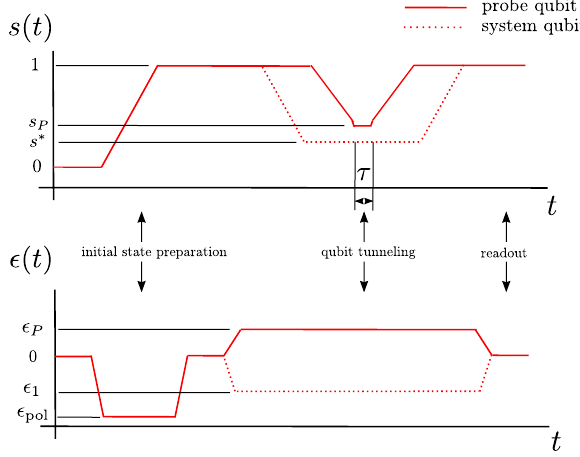
FIG. 7. Typical waveforms during QTS. We prepare the initial state by annealing probe and system qubits from s ¼ 0 to s ¼ 1 in the presence of a large polarization bias ϵ . We then bias the pol system qubit q 1 (to which the probe is attached) to a bias ϵ 1 and the probe qubit to a bias ϵ . With these biases asserted, we then P adjust the system qubits ’ annealing parameter to an intermediate point s (cid:4) and the probe qubit to a point s and dwell for a time τ . P Finally, we complete the anneal s → 1 and readout the state of the